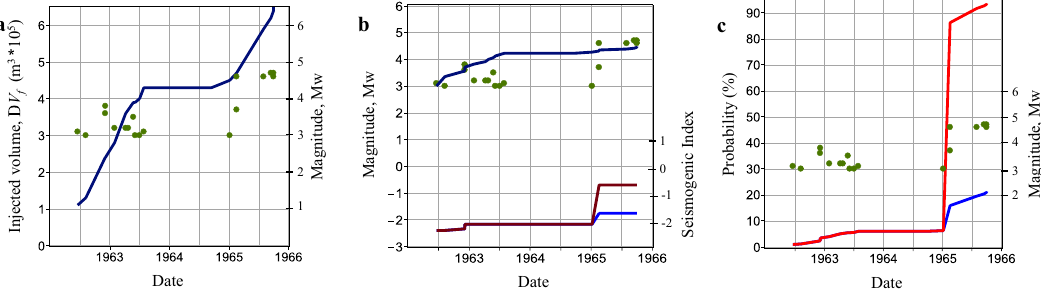
Fig. 4 Mw ≥ 3 earthquakes (green points) at the Denver Rocky Mountain Arsenal wastewater injection site. The earthquakes and injected volumes are taken from published data 4, 68 . a Earthquake occurrence versus cumulative injected fl uid volume over time (dark-blue line). b Expected maximum magnitude 24 (dark-blue line), sup Σ ð t Þ assuming independent injection phases (dark-red line), and sup Σ ð t Þ assuming the total stimulation period is a single continuous injection (blue line). c Exceedance probability of Mw > 5.5 events at the Denver Rocky Mountain Arsenal wastewater injection site. The red and blue lines correspond to the upper and lower sup Σ ð t Þ estimates ( b ),